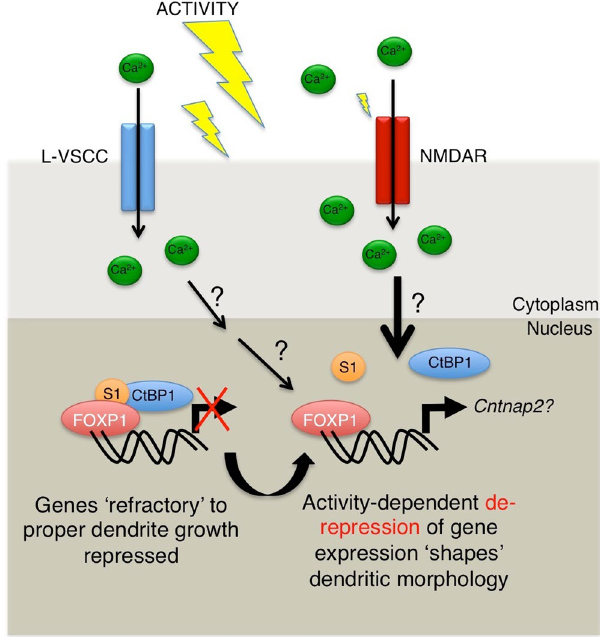
Figure 6. SUMOylation of FOXP1 regulates dendritic outgrowth and length. Taken together, our data suggests a model in which activity-dependent signals trigger the dynamic reduction of FOXP1 SUMOylation, as well as co-repressor recruitment, thereby modulating its function as a crucial transcriptional regulator that tonically controls the normal developmental maturation of neurons. We believe timely deSUMOylation of FOXP1 allows neurons to appropriately convert such activity-dependent cues into programs of gene-expression that finely ‘shape’ and ‘mature’ the dendritic tree (as opposed to continual growth) to aid and guide the structural and functional maturation of neuronal